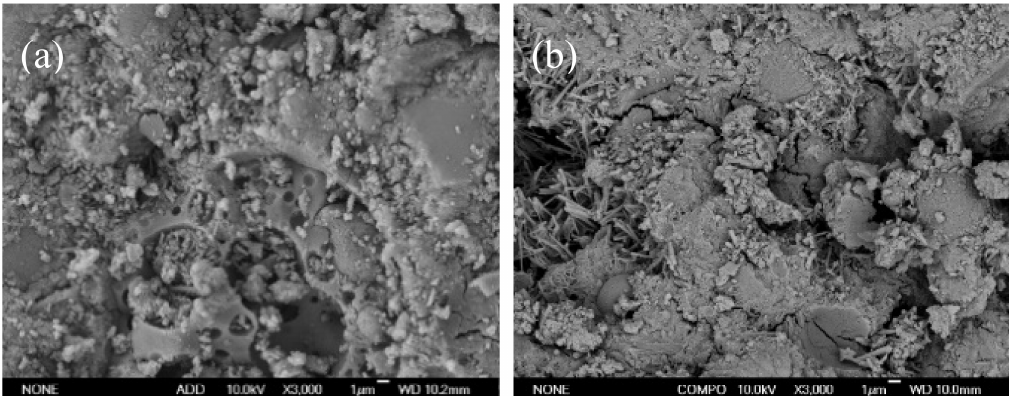
Figure 6. SEM photo of F1 and F3 groups at 28 d: ( a ) F1, ( b )